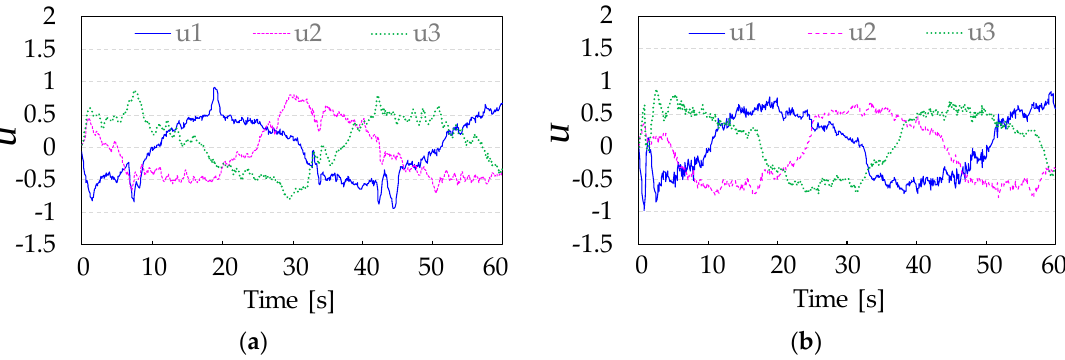
Figure 14. Control inputs of the robot: ( a ) with robust compensation and ( b ) non ‐ robust compensation.